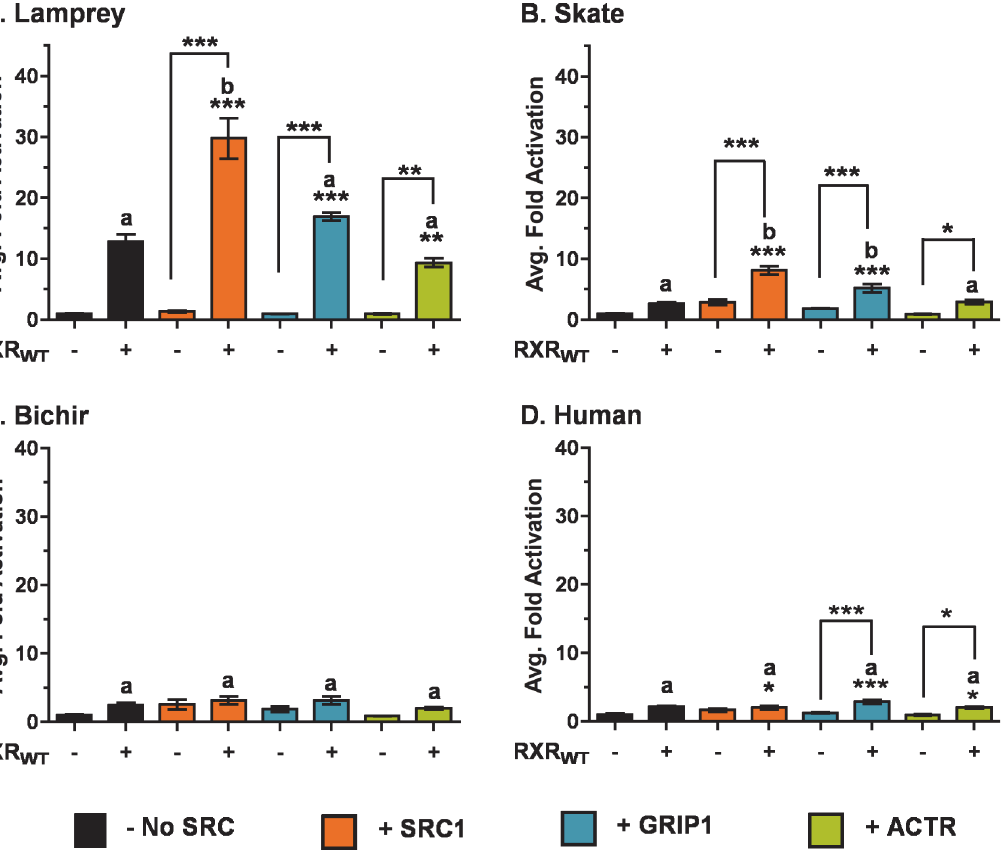
Fig 7. Influence of overexpressed SRC/p160 coactivators on VDR transactivation in response to 1, 25D 3 . The above graphs depict (A) lamprey VDR, (B) skate VDR, (C) bichir VDR, and (D) human VDR. HepG2 cells were transiently transfected with pSG5-VDR, the XREM-Luc reporter, and the pRL-CMV internal luciferase control as described previously in Materials and Methods. Select assays were cotransfected with pSG5-SRC1 (orange bars), pSG5-GRIP1 (blue bars), pSG5-ACTR (yellow bars), or no SRC/p160 coactivators (black bars). Assays were conducted both in the presence (+) and absence (-) of pCDNA-RXR WT . Cells were treated with 120 nM 1, 25D 3 for 24 hours. VDR response was measured via dual-luciferase assays as described. Data are represented as the average fold activation normalized to VDR alone ± SEM (n = 4). Asterisks indicate significance: *** = p < 0.001, ** = p < 0.01, * = p < 0.05. Asterisks above brackets indicate the combination of RXR WT the indicated SRC/p160 coactivator significantly increased VDR transactivation compared to the SRC/p160 coactivator in the absence of RXR WT . The letter “ b ” indicates the combination of both RXR WT and the indicated SRC/p160 coactivator had a greater effect on VDR transactivation compared with VDR + RXR WT in the absence of the SRC/p160 coactivator (black bar). The letter “ a ” indicates that no difference in VDR transactivation was observed in the presence of both RXR WT and the indicated SRC/p160 coactivator vs. VDR + RXR WT in the absence of the SRC/p160 coactivator. (p <